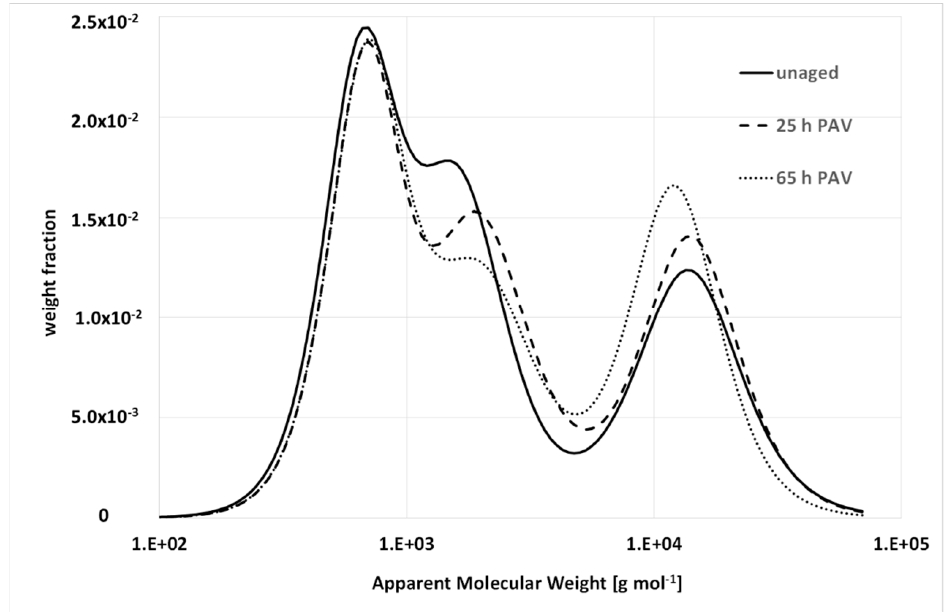
Figure 13. BMWD of a PMB with 5% SBS before and after prolonged artificial aging (25 and 65 hours of PAV, respectively). All details are given in [32].